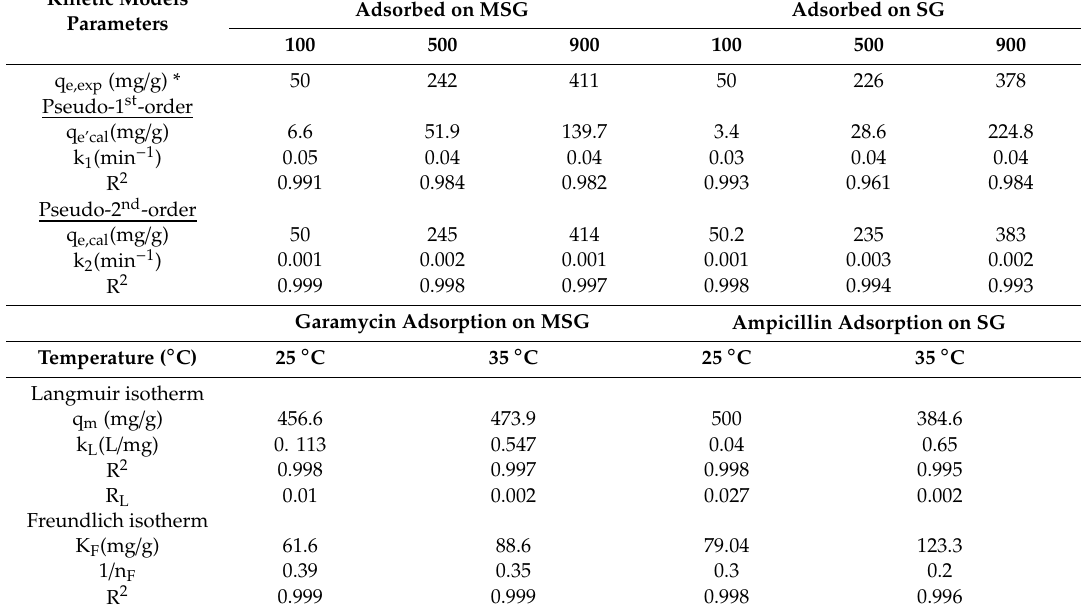
Table 1. Parameters and determination coe ffi cients of the kinetic and isotherm models for Garamycin and Ampicillin adsorption on prepared MSG and SG.